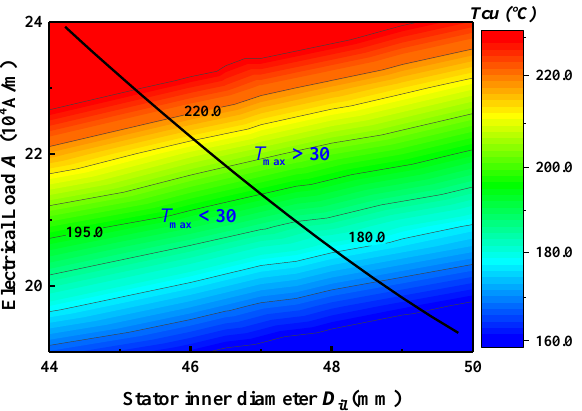
Figure 8. Winding temperature rise with different stator inner diameter and electrical load for 10 s.